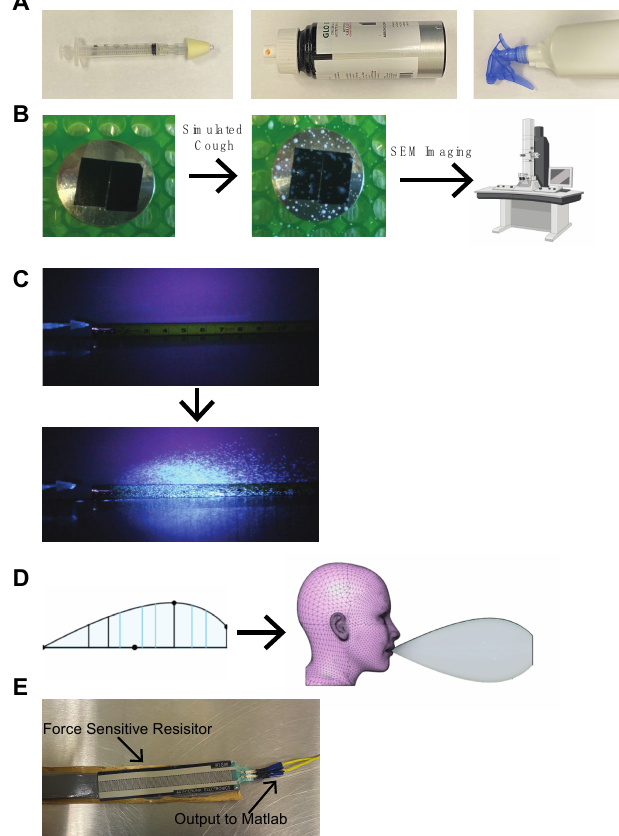
Figure 1. Overview of Experimental Strategy. ( A ) Images of the three cough simulators: MAD Nasal, GloGerm TM MIST, and the spray gun (left to right). ( B ) A conductive mounting tab with 8 mm carbon tape is shown before and after collecting droplets. ( C ) Still frames from the video used to quantify simulated cough velocity for MAD Nasal before and after a simulated cough. ( D ) The 2D reconstruction for a MAD Nasal simulated cough and a profile of the resulting 3D reconstruction on Fusion 360. ( E ) A photograph of the force-sensing resistor used for the force measurement experiment.